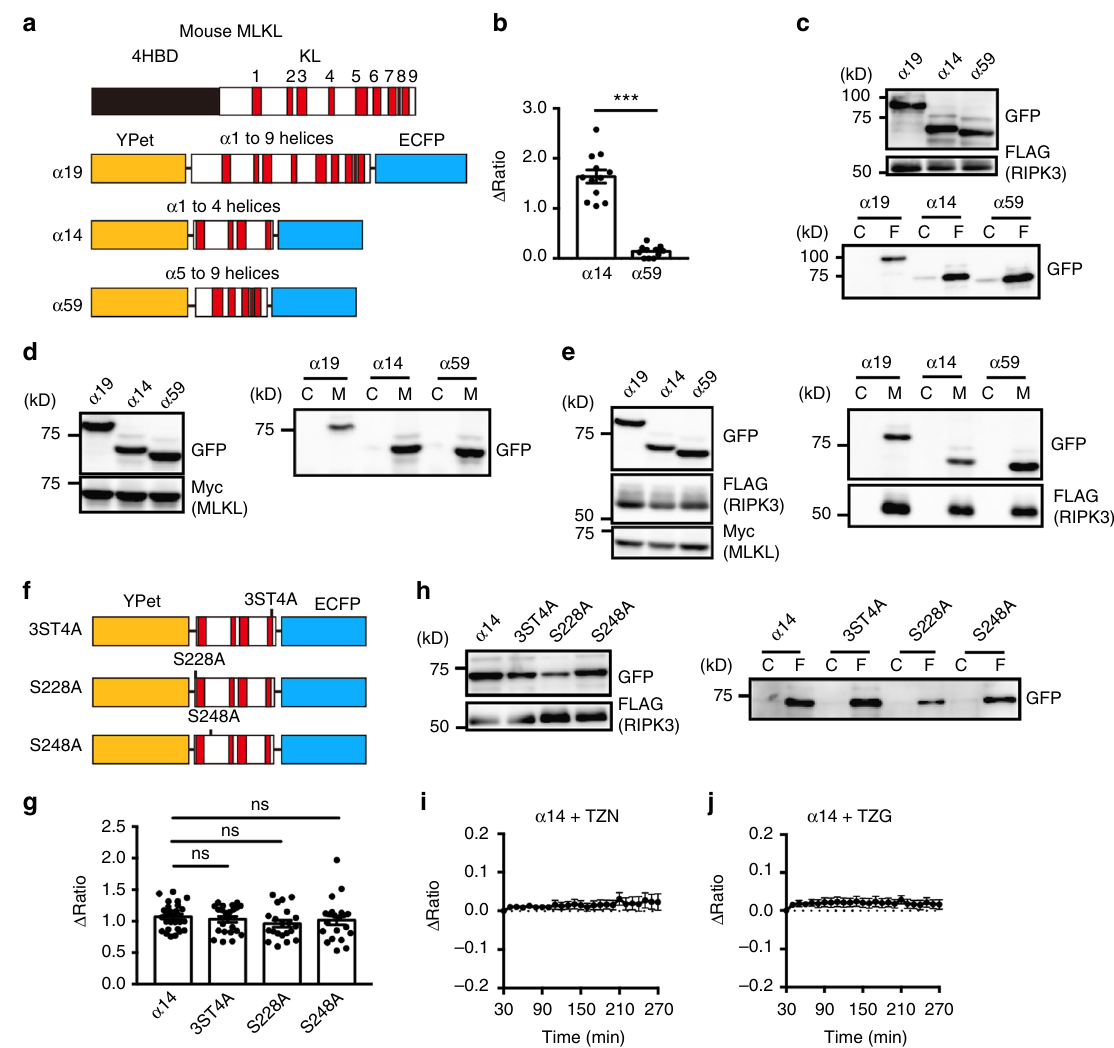
Fig. 1 Development of a FRET biosensor that monitors necroptosis. a Domain structures of murine MLKL and designed FRET biosensors. 4HBD and KL indicate four-helical bundle and kinase-like domains, respectively. Red boxes indicate each α helix. b α 14 monitors necroptosis. L929 cells were transiently transfected with α 14 or α 59, and then treated with TZ. The FRET/CFP ratio was calculated and analyzed as in Methods, and maximum changes of the FRET/CFP ratio are shown. Each dot indicates individual cell ( n = 12 cells). Statistical signi fi cance was determined using the unpaired two-tailed Student ’ s